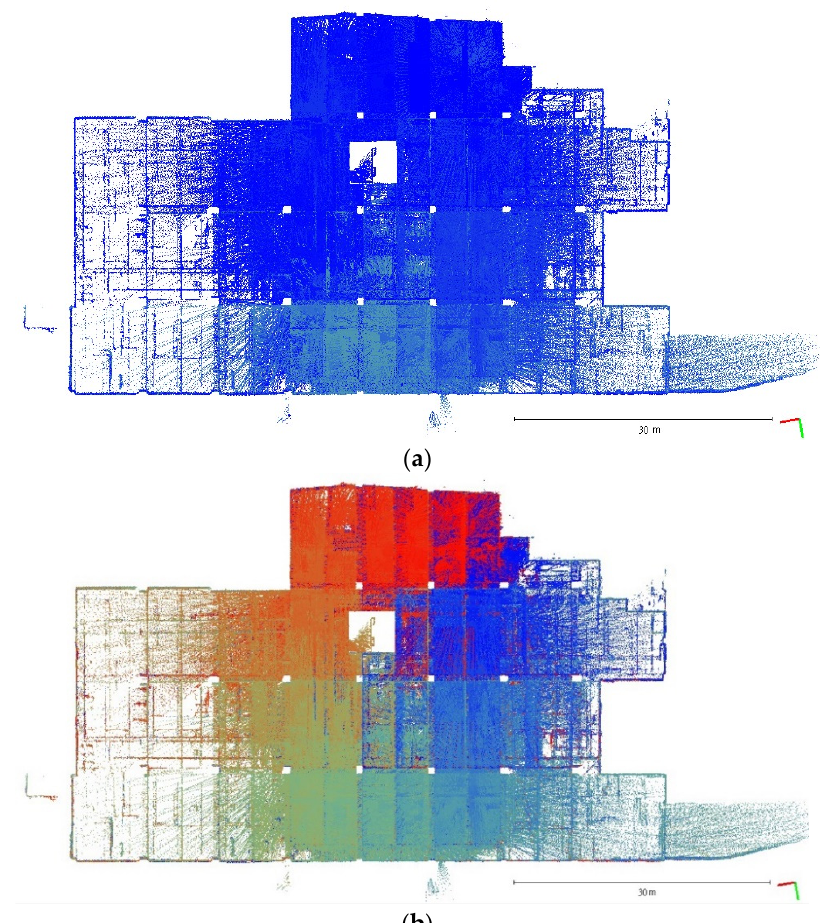
Figure 7. The top view of calibration dataset DATA3. ( a ) Point cloud colored by SLAM condition; ( b ) Point cloud colored by scanning time.